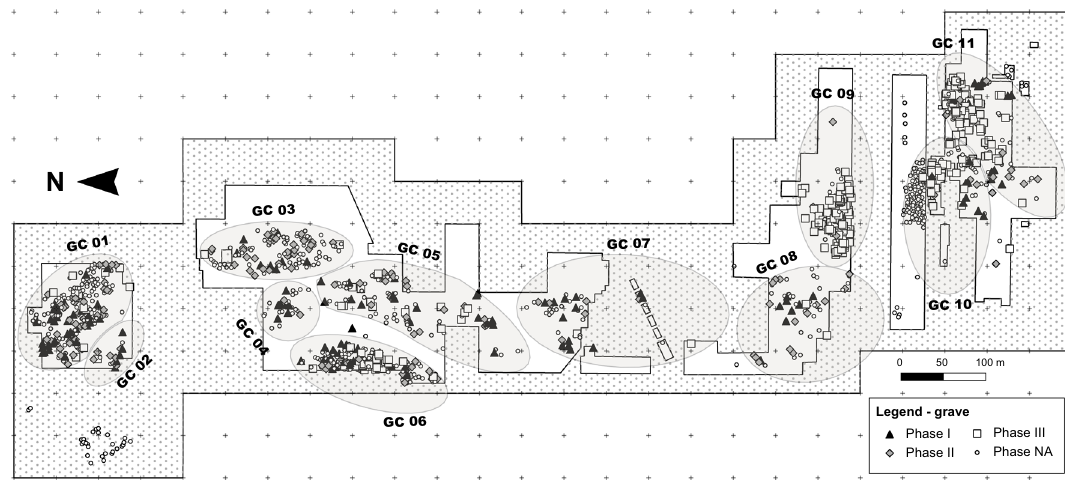
Figure 3: Cemetery layout of Dunaújváros after Vicze ( 2011 ) with typochronological dating of the single burials and their grave cluster ( GC ) a ffi